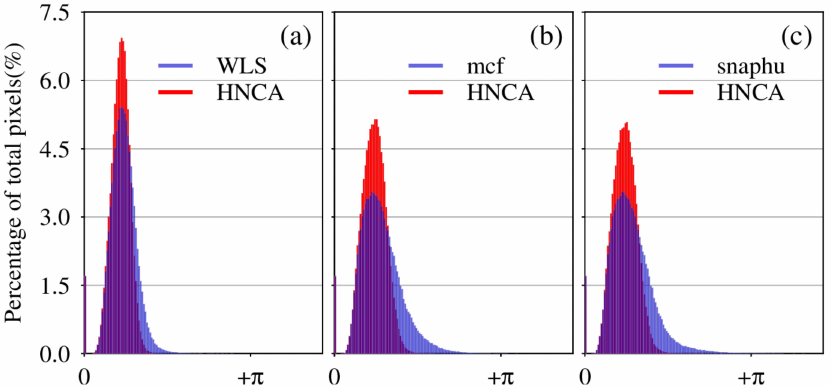
Figure 10. The statistical distribution of the PSD between the proposed method and the traditional method: ( a ) based on the WLS method; ( b ) based on the mcf method; ( c ) based on the snaphu